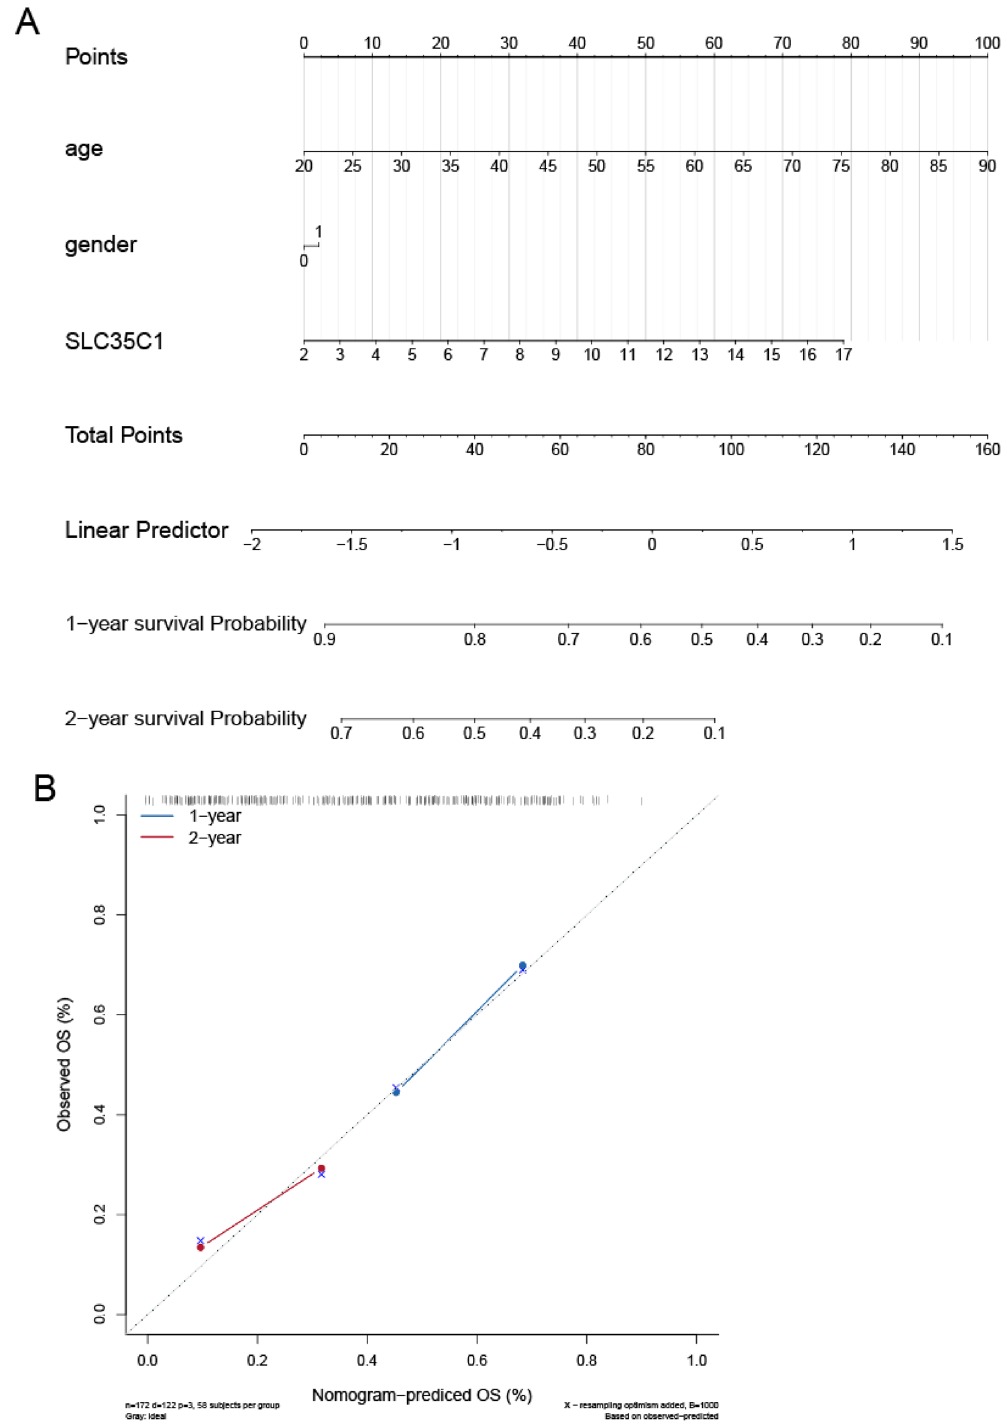
Figure 10. Establishment and validation of the prognostic nomogram. ( A ) Nomogram based on the SLC35C1 signature and clinical information for prediction of the 1- and 2-year OS in patients with glioma in the TCGA dataset. ( B ) The calibration curves is used to verify the consistency of predicted and actual 1-,2-year